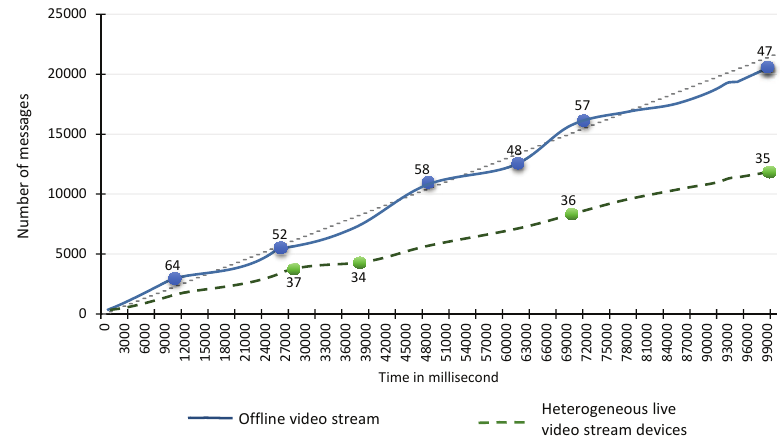
Figure 14. Performance testing of Video Stream Acquisition Service (VSAS) and Video Stream Producer (VSP).